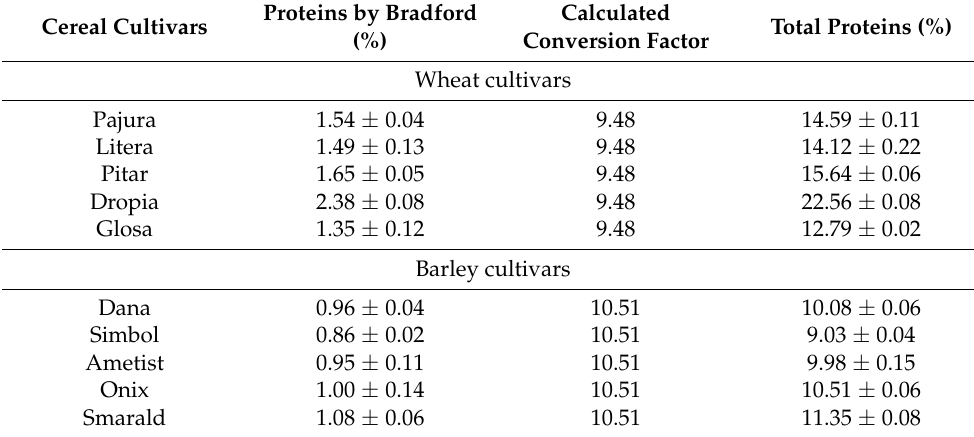
Table 7. The results obtained using the extrapolation method (means values ± standard deviation). Cereal Cultivars